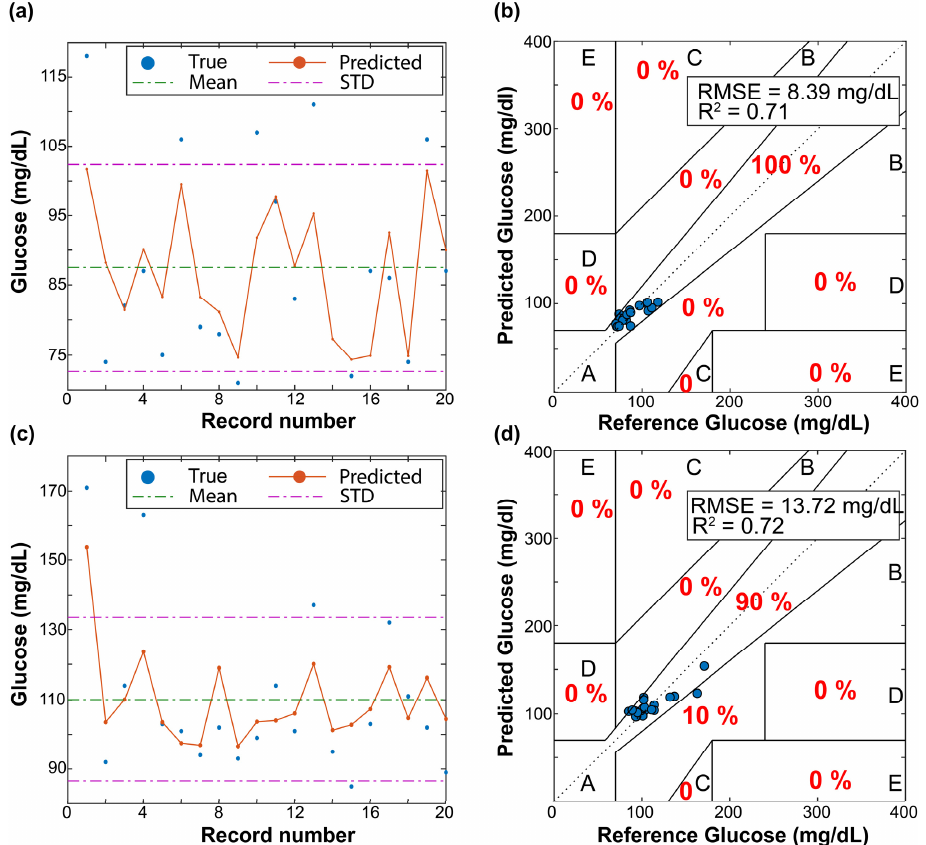
Figure 6. Performance of the best-trained model in unseen instances for both subjects from the UofM dataset. Panels ( a , c ) show the predicted and target glucose concentrations from unseen data. The Clarke Error Grids are shown in panels ( b , d ). RMSE and R 2 values of the best model are reported in panels ( b , d ). We also report the percentage of instances (red font) falling in each region of the Clarke Error